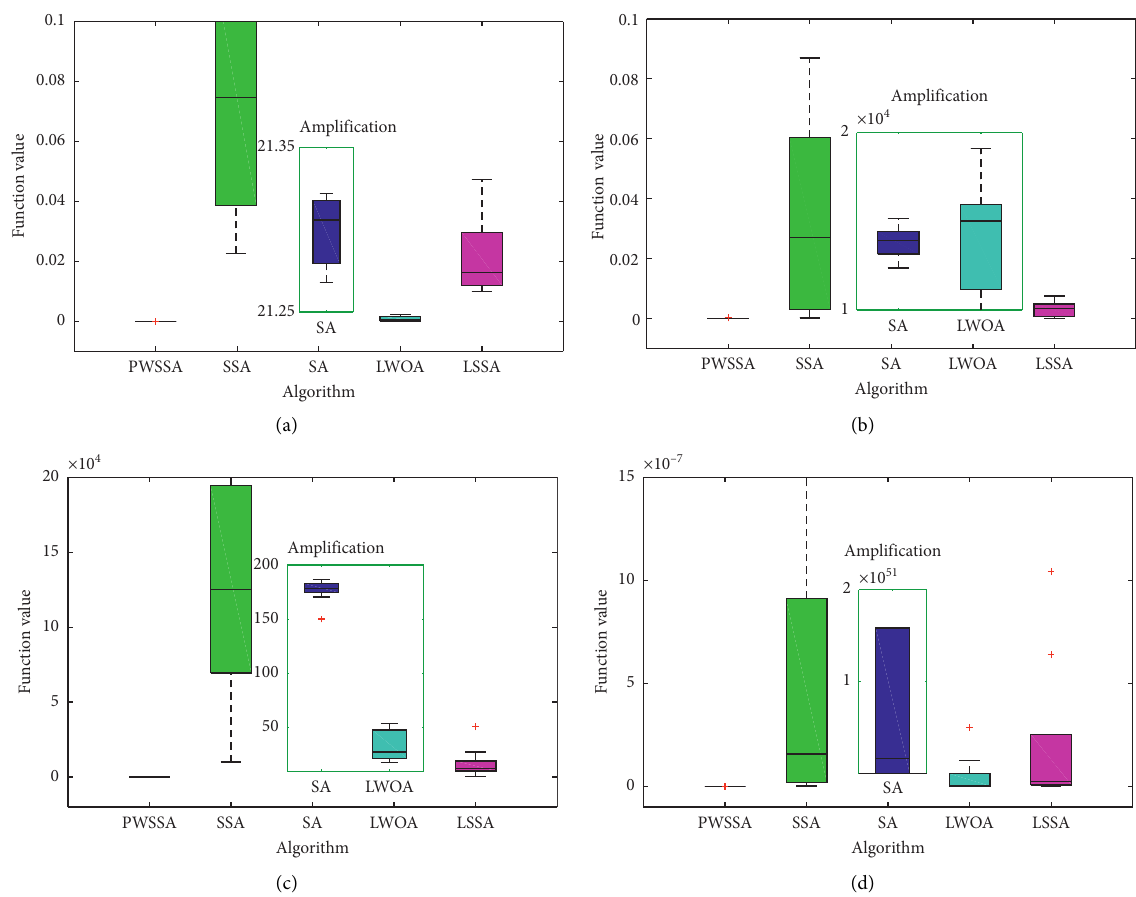
Figure 5: Box-plot charts of functions ( D � 100). (a) f